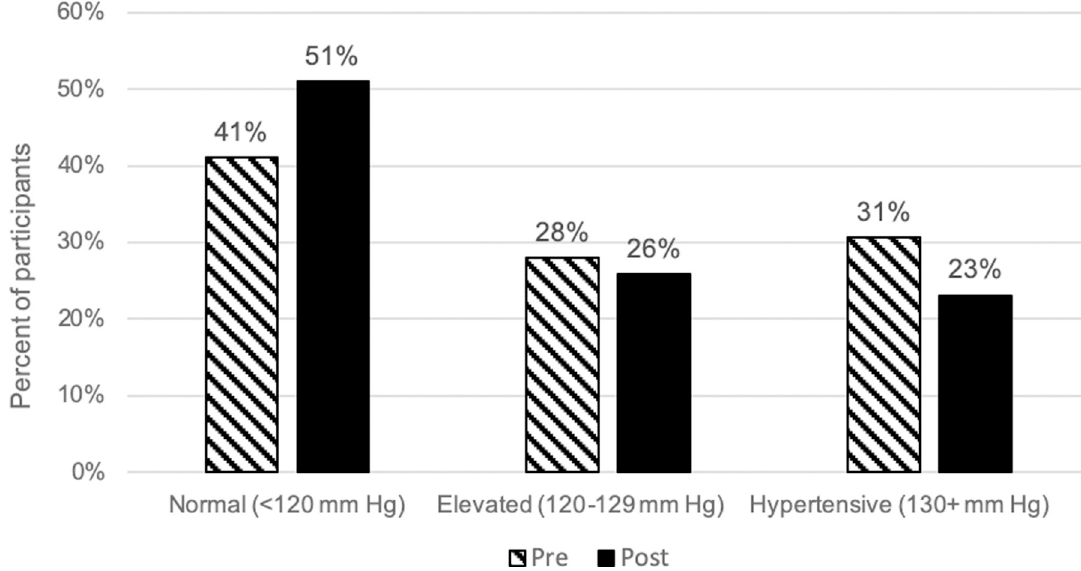
Fig 3. Percent of study participants categorized by systolic blood pressure categories, pre and post the River’s Edge experience.